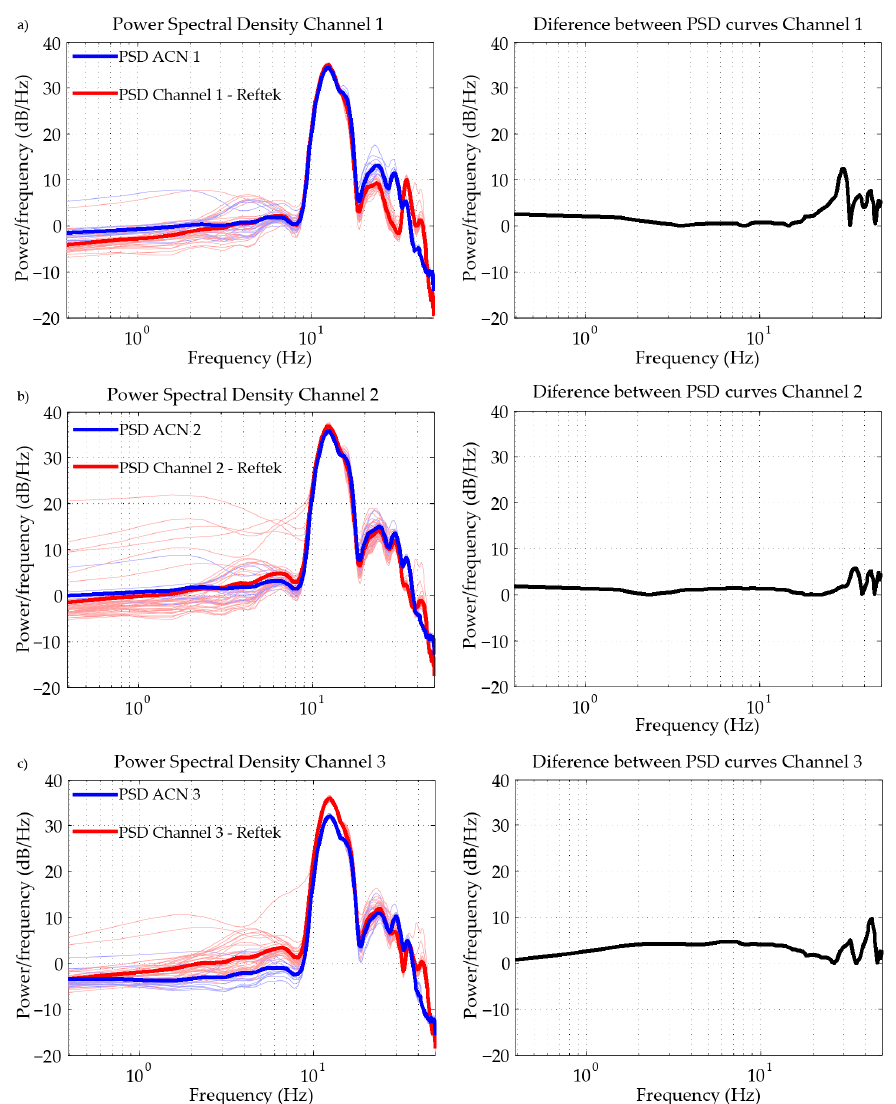
Figure 16. Mark L-4 sensors connected to the commercial equipment, Reftek, and the developed acquisition system, Geophonino-W.